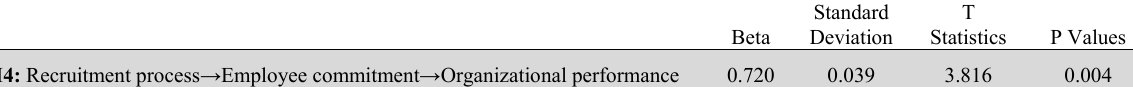
Standard T Beta Deviation Statistics P Values